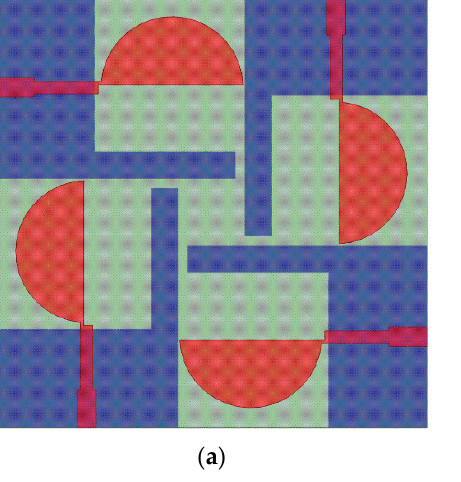
Figure 2. ant3: ( a ) geometry; ( b ) S-parameters.